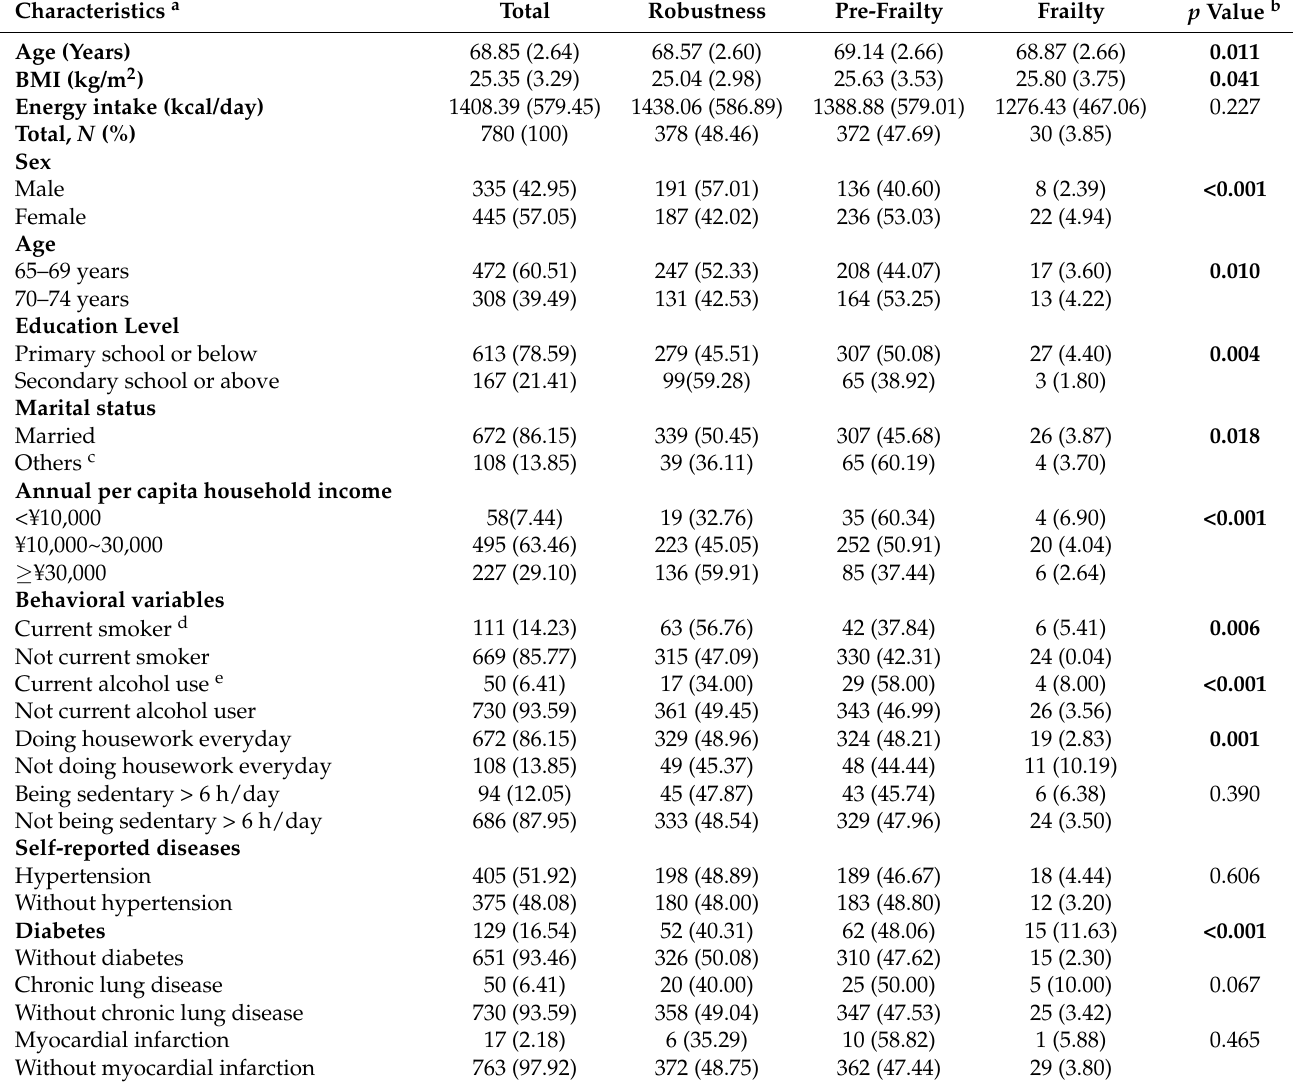
Table 2. Characteristics of participants and distribution of frailty ( n =